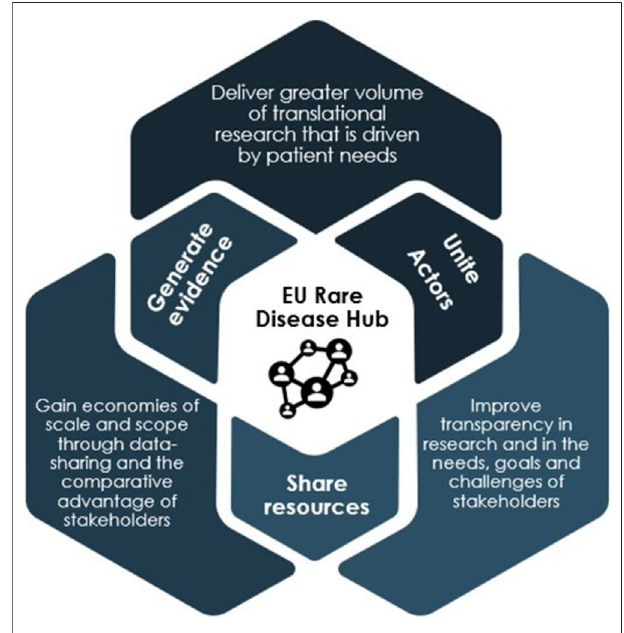
FIGURE 7 | Eu rare disease hub. Source: The OD Expert